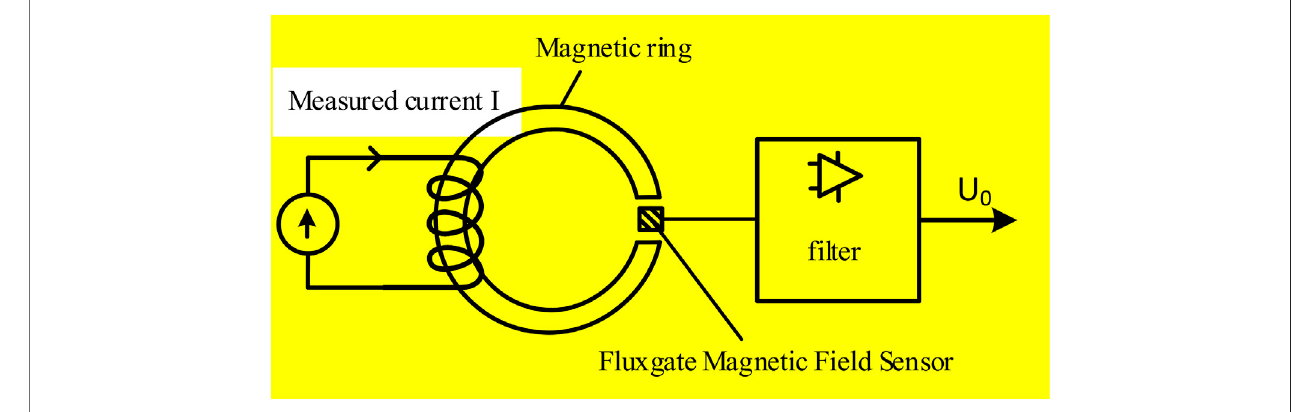
FIGURE 1 | Schematic diagram of fl uxgate current sensor measurement.